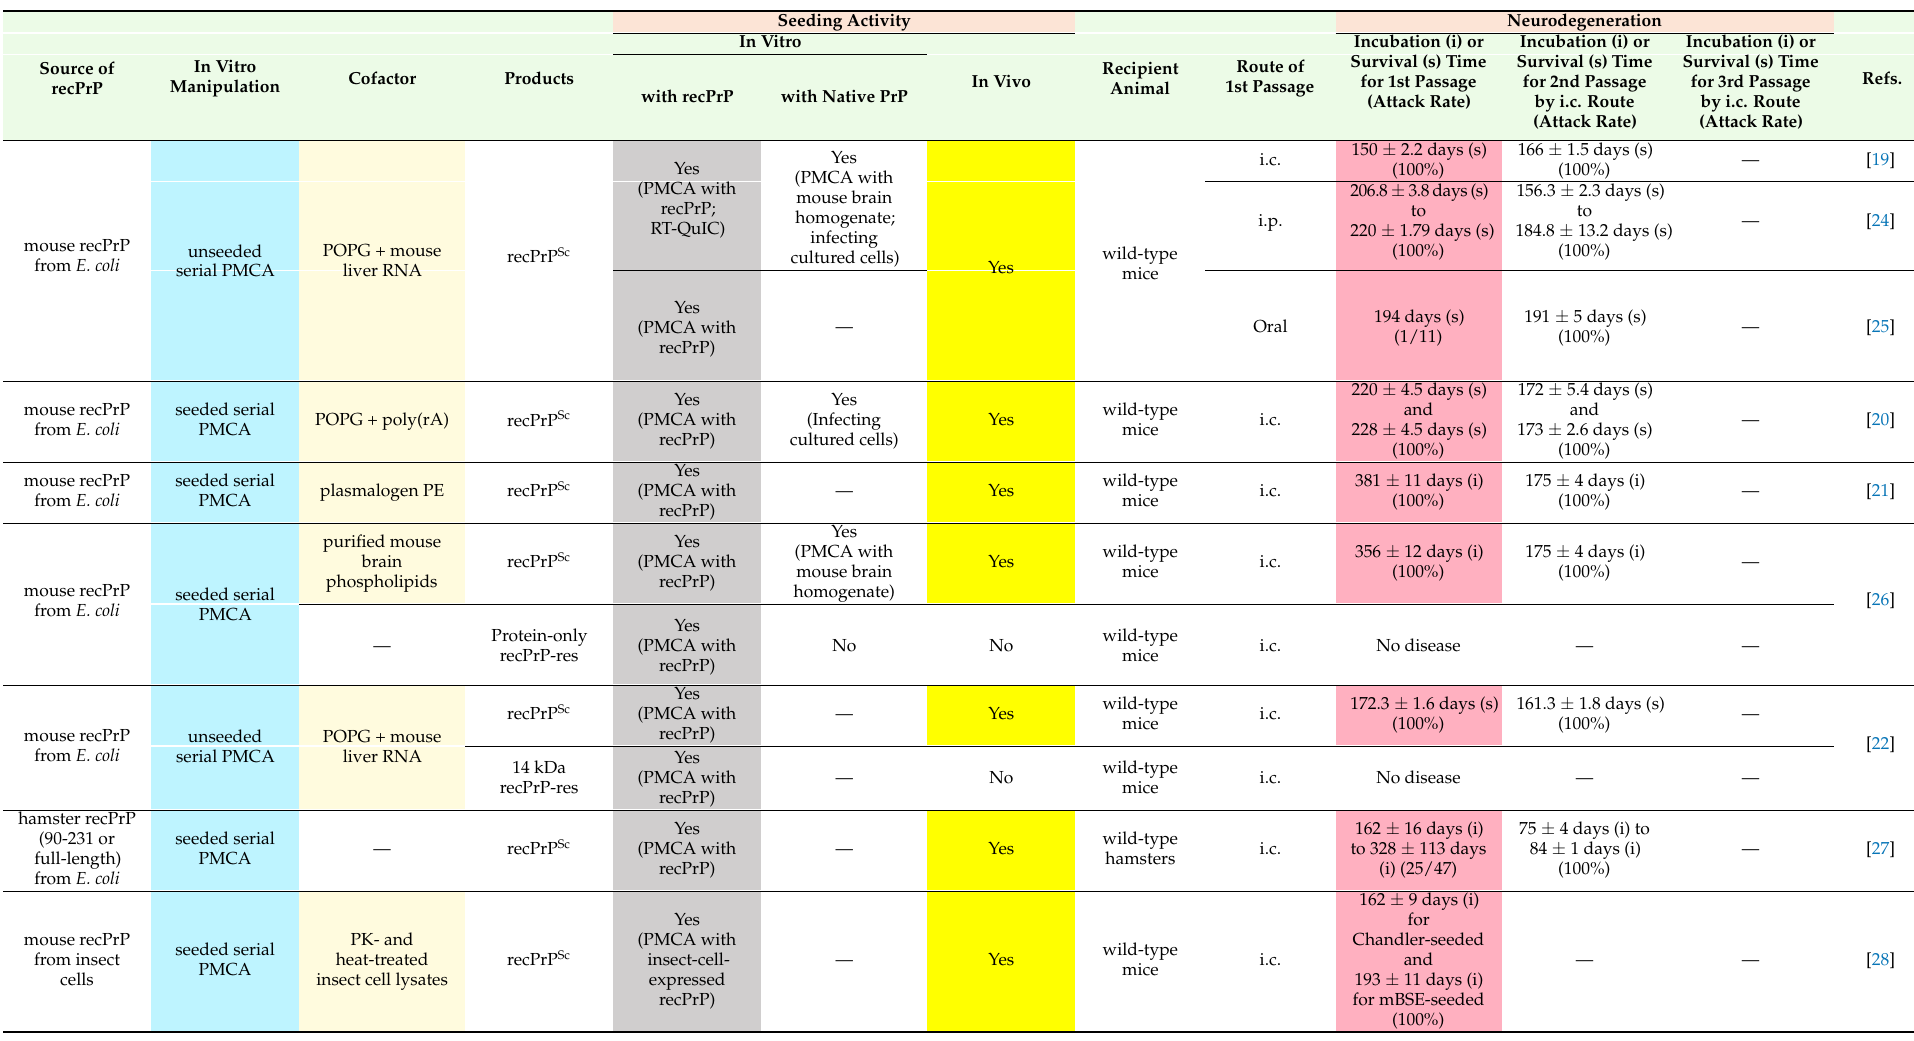
Table 1. Studies of misfolded recPrP